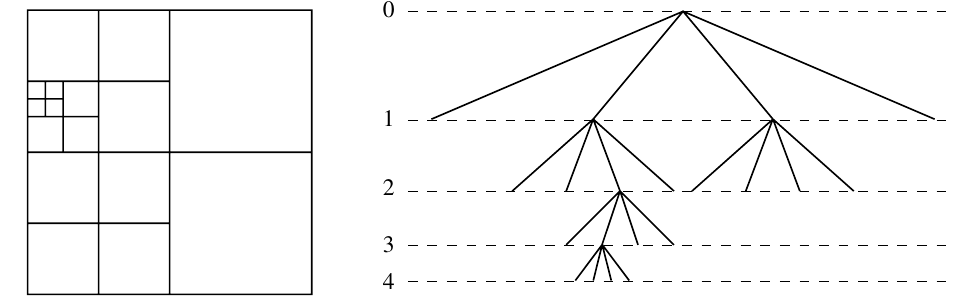
Fig. 1. An example of quadtree discretisation (left) together with its logical representation (right). The level of the cells in the tree are also given.